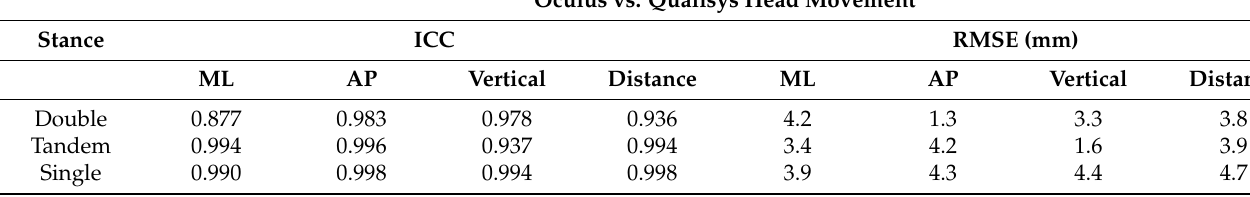
Table 1. The average ICC and RMSE values for the Head movements recorded from the Qualisys and the Oculus Quest systems. The values are for the three axes (ML, AP and Vertical) and the calculated distance (sway) are presented for the three different stances (Double, Tandem, Single). ICC values can be interpreted as follows: ICC > 0.8 is excellent; ICC < 0.8 > 0.6 is good; ICC < 0.6 > 0.4 is moderate, while ICC < 0.4 is poor [19]. RMSE values are measured in mm with values closest to 0.0 indicating the highest levels of precision.